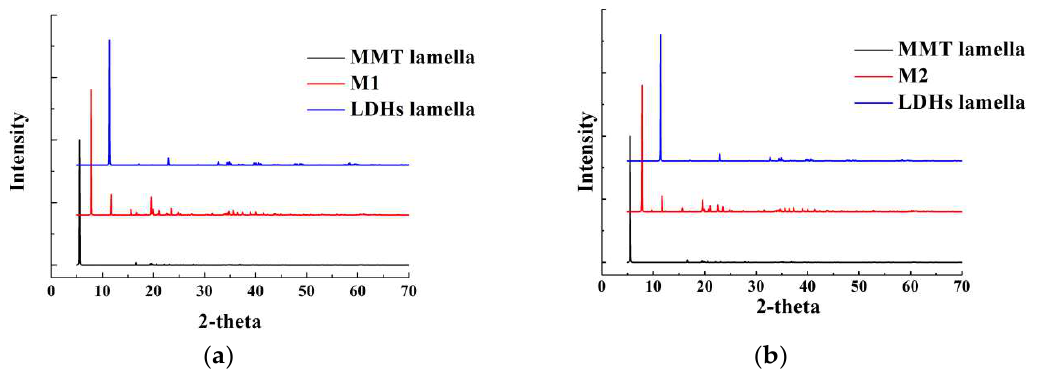
Figure 6. XRD Simulation of different material structures (using Cu K-alpha radiation); ( a ): XRD pattern of M1, MMT and LDHs; ( b ): XRD pattern of M2, MMT and LDHs.